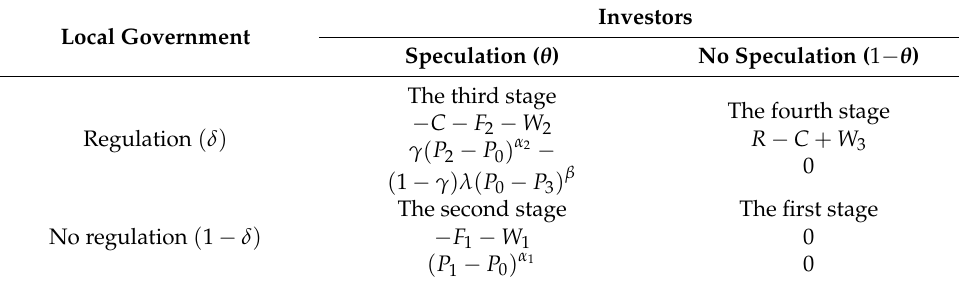
Table 1. The game payoff matrix of the local government and